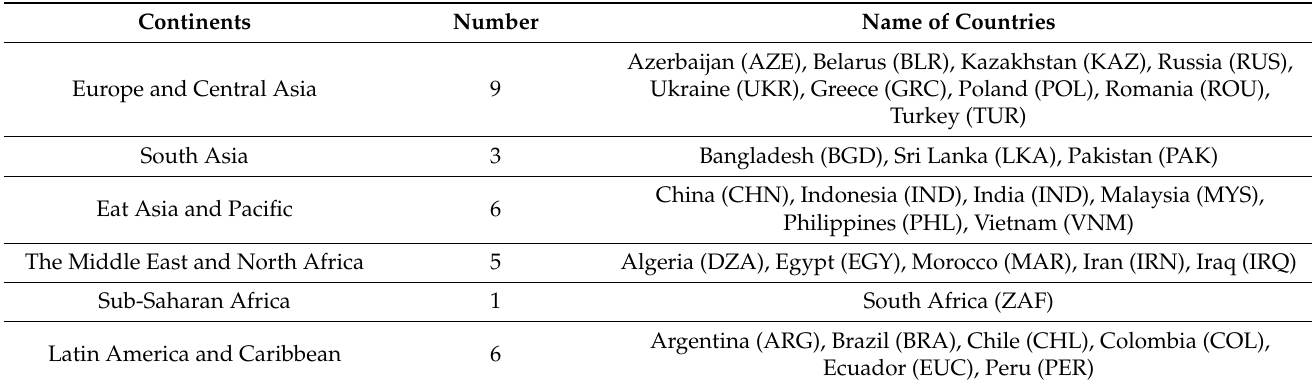
Table 2. Region-wise distribution of developing